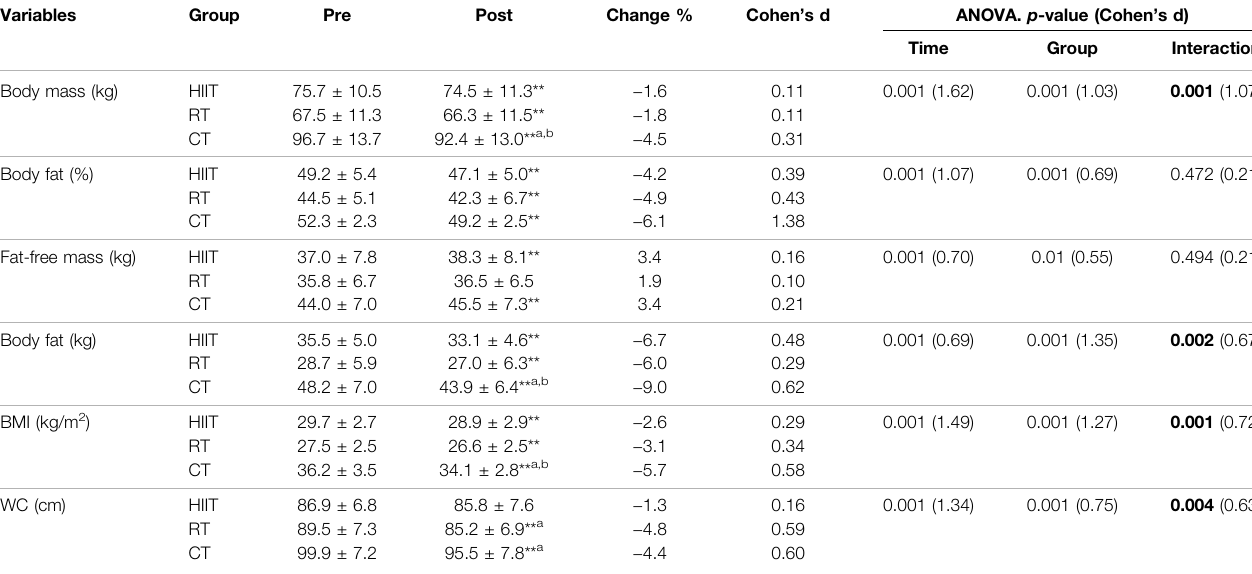
TABLE 4 | Effects of 9 weeks of training on participants ’ anthropometric characteristics and body composition (mean ± SD). Variables Group Pre Post Cohen ’ s d ANOVA. p -value (Cohen ’ s d)